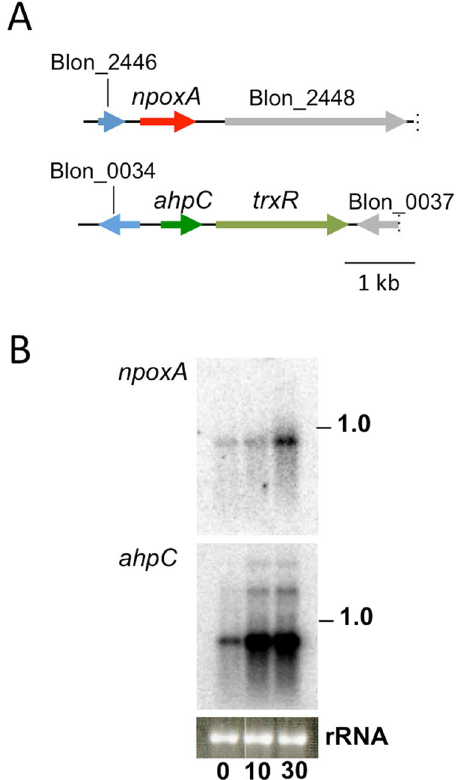
Figure 5. Genome structures and gene expression profiles of B. infantis npoxA and ahpC . ( A ) Genome structure of the npoxA (upper) and the ahpC (lower). ( B ) Northern blot analyses of 5 µ g of B. infantis total RNA probed with npoxA or ahpC . 0, immediately before the start of aeration with 5% O 2 in the mid-exponential phase; 10, after 10 min; 30, after 30 min. The estimated sizes of the observed transcripts are indicated on the right. Ethidium bromide staining of the ribosomal RNA (rRNA) to confirm equal RNA loading is shown below the autoradiogram. The membranes were reused for reprobing different